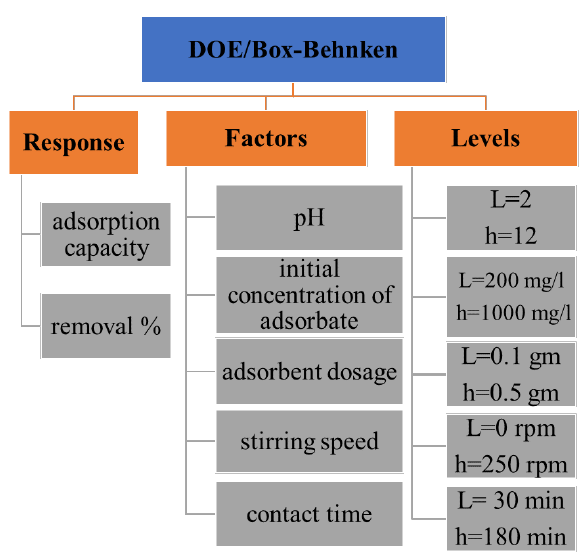
Fig. 2. Design of experiment.